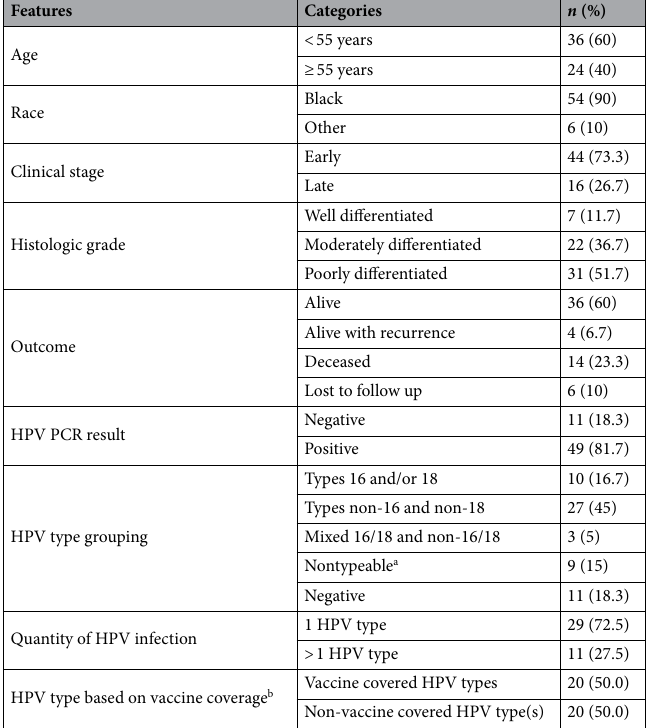
Table 1. Demographic and clinical features of patients with squamous cell carcinoma of the cervix. a Nontypeable HPV genotypes are positive only for the common high-risk HPV â-globin gene. b Vaccine covered high-risk HPV genotypes are included in the FDA-approved nonavalent vaccine, Gardasil (16, 18, 31, 33, 45, 52 and